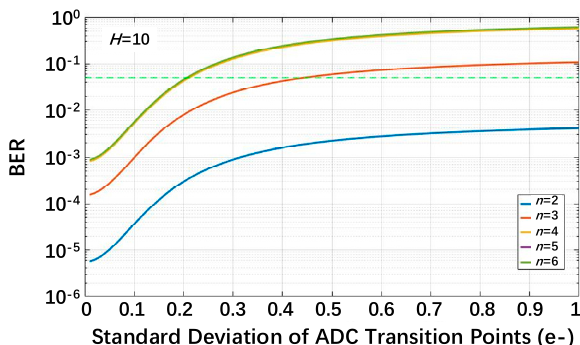
Figure 5. The BER as a function of standard deviation U thn for different QIS bit depths for exposure H =10 and read noise U n = 0.15e − .